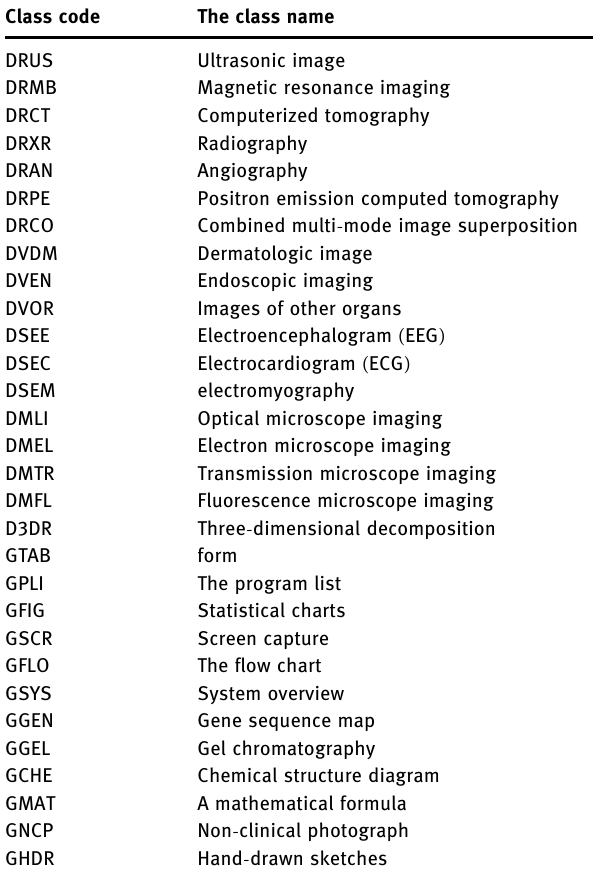
Table 1: 30 Class codes for multi - label classi fi cation Class